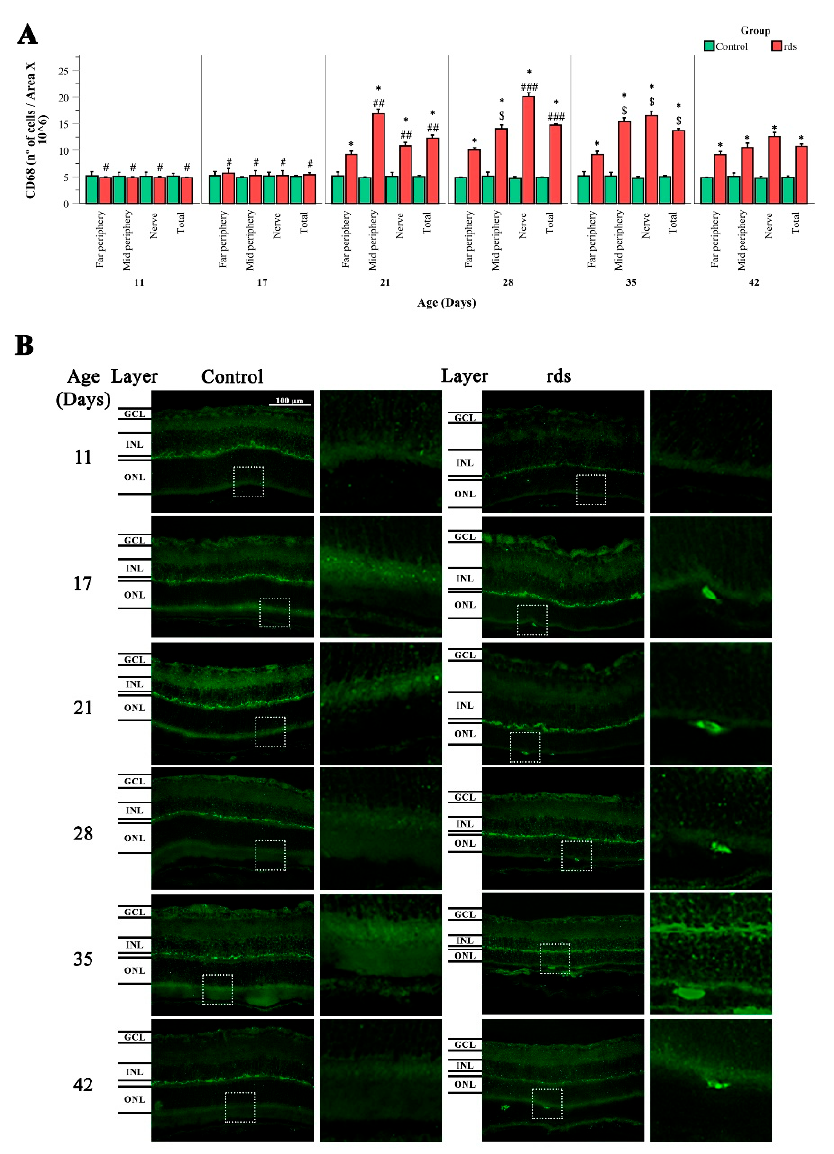
Figure 11. Changes in microglia activation in the retinas of rds mice. ( A ) Number of retinal CD68- positive cells divided by area x 10 6 in three retinal areas (far periphery, midperiphery, and near the nerve) at different postnatal ages (PN11, PN17, PN21, PN28, PN35, and PN42) (* p < 0.0001 vs. control group on the same postnatal day; # p < 0.0001 vs. rds PN21, PN28, PN35, and PN42; ## p < 0.05 vs. rds PN28, PN35, and PN42; ### p < 0.0001 vs. rds PN35 and PN42; $ p < 0.0001 vs. rds PN42). Four mice per group were used and three histological sections of one retina of each mouse were quantified. ( B ) Representative micrographs of retinal sections stained with CD68 antibody in control and rds retinas at PN11, PN17, PN21, PN28, PN35, and PN42 (microscope 40 × magnification photos).